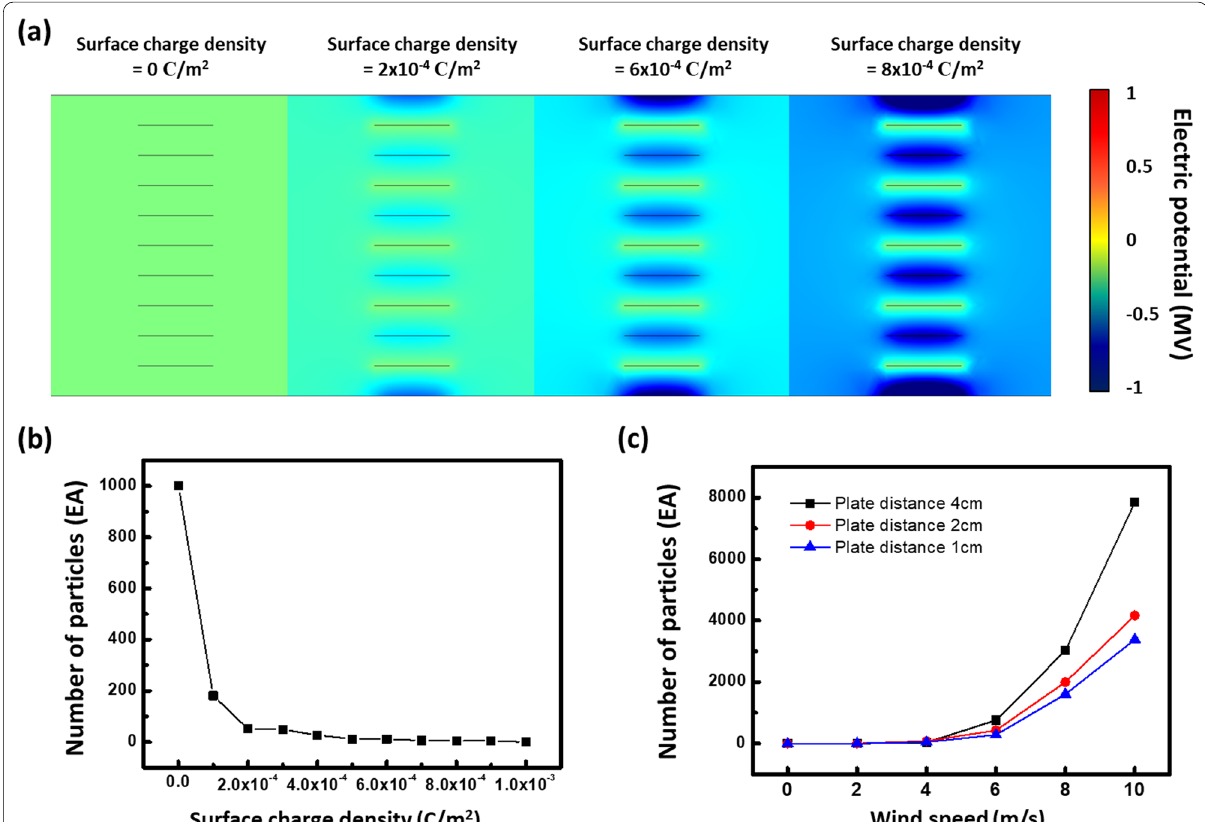
Fig. 5 COMSOL simulation of the dust collection at the secondary plates of the filter for air filtration. a The electric potential in the secondary plates, which is the dust collecting part, for an increasing surface charge density at the PVDF‑coated Al plates. b The number of particles getting through the secondary plates without filtration as a function of the surface charge density. c The number of particles getting through the secondary plates without filtration as a function of the particle velocity at various plate